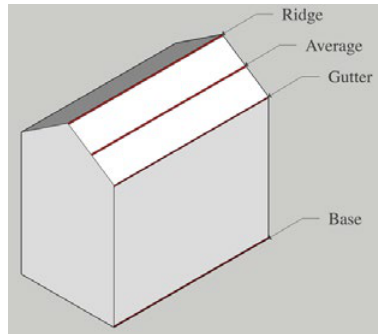
Figure 9. Elevation data for each building in the case study.